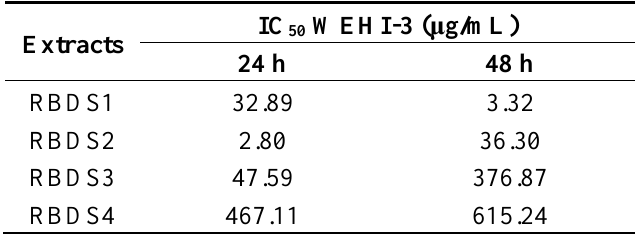
Figure 2. Effect of ( A ) RBDS1; ( B ) RBDS2; ( C ) RBDS3; and ( D ) RBDS4 on cell viability analyzed using MTT assay. Table 4. The 50% inhibitory concentration (IC 50 ) of the fractions on WEHI-3 cancer